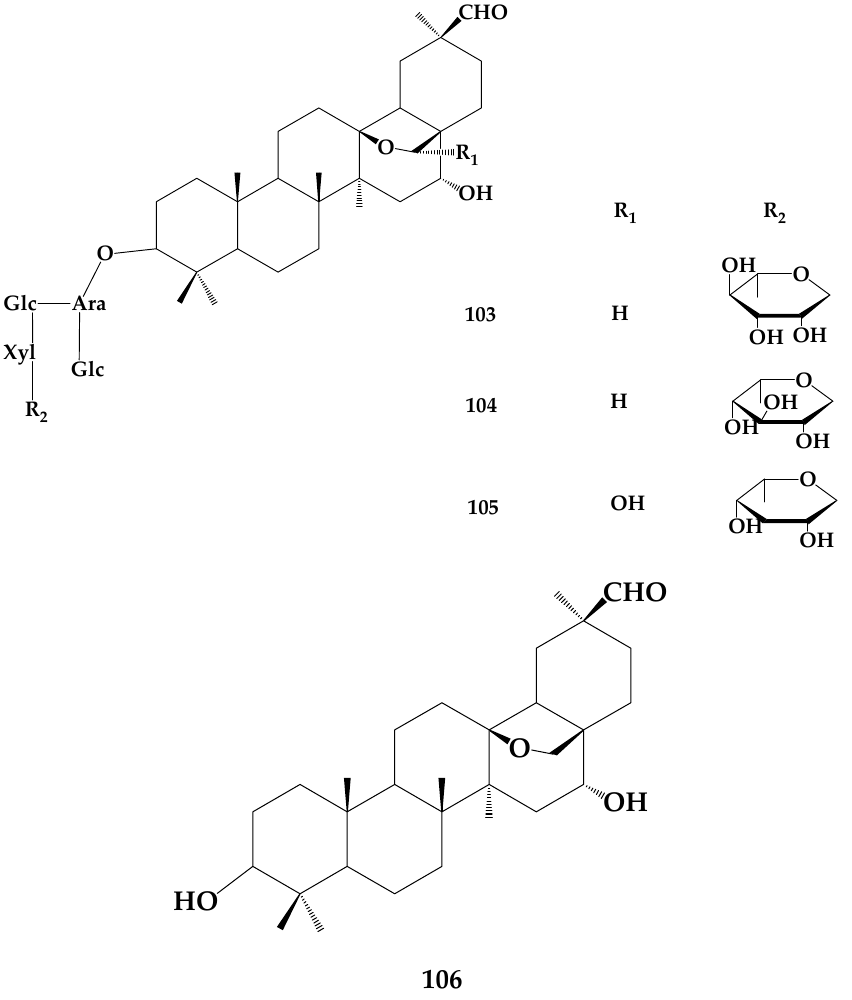
Figure 18. The chemical structures of compound 103–106